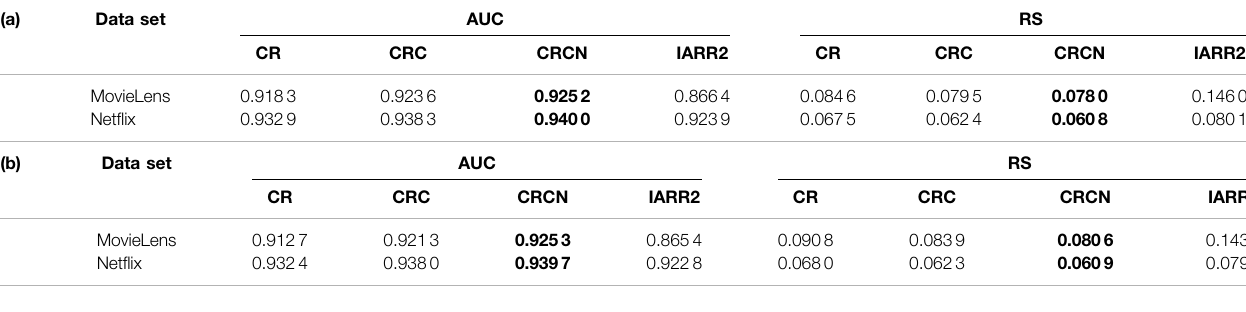
TABLE2| AUCandRSvaluesofdifferentmethodsontworealdatasets(A)withrandomspammersand(B)withmaliciousspammers.Theparameters ω and ρ arethesame as those in Figure 3 . The results are averaged over ten independent realizations. The most remarkable value in each row is emphasized in